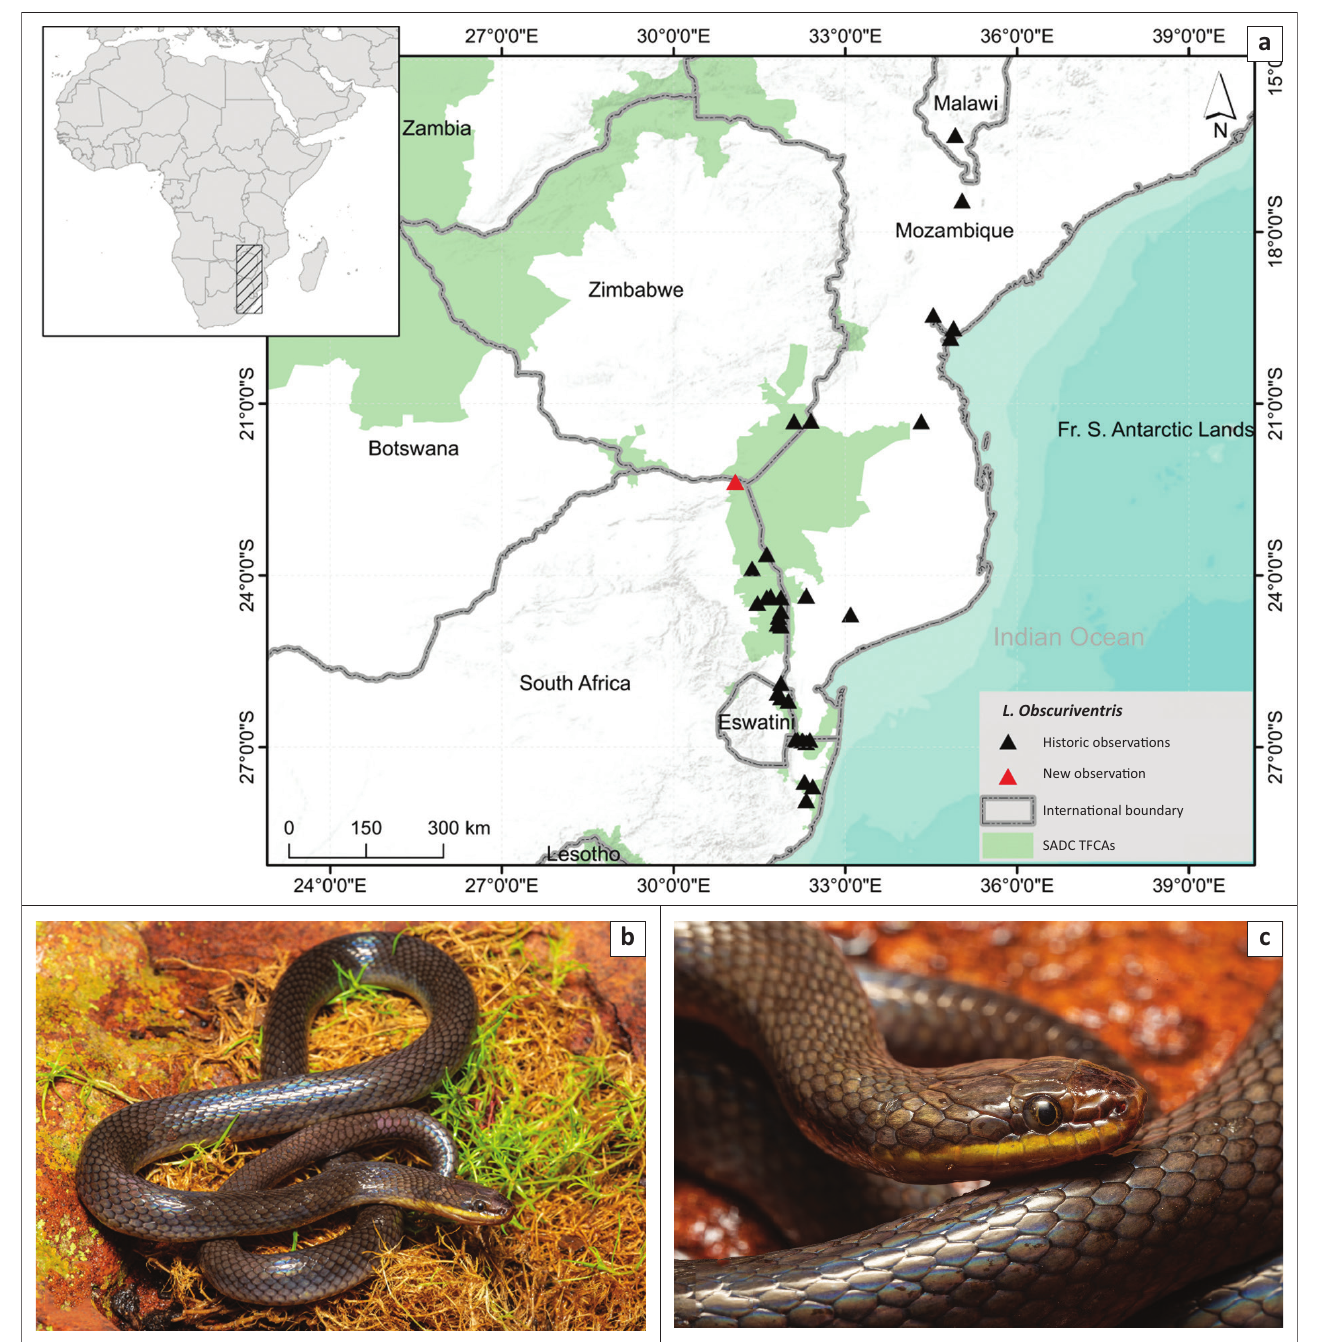
FIGURE 1: (a) Current global distribution of Lycodonomorphus obscuriventris with black triangles denoting historical localities and the red triangle denoting the new sample used in this study from the Makuleke Contractual National Park. (b) Full body photograph of PEM R27786. (c) Head shot of PEM